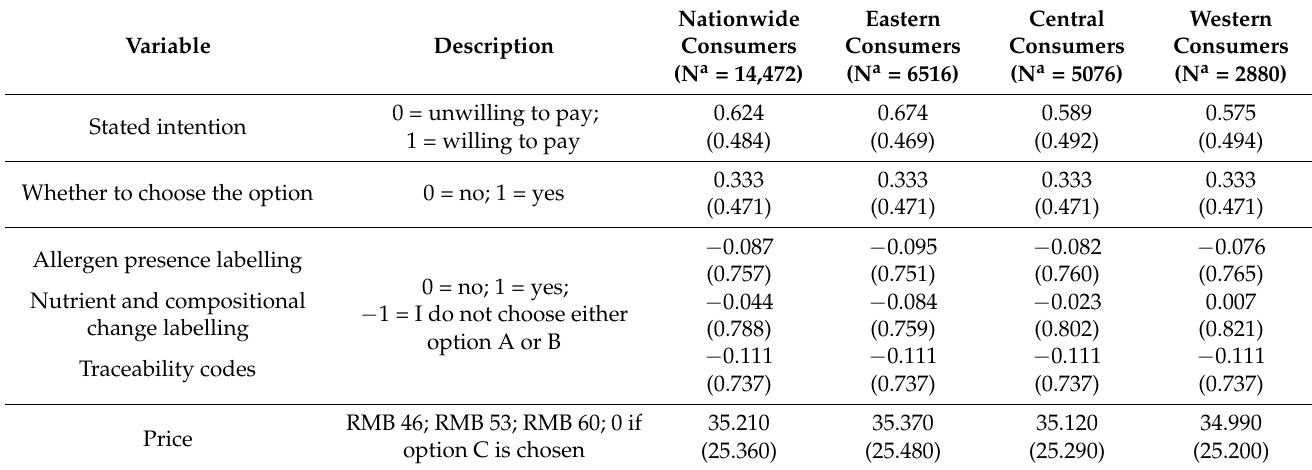
Table 3. Definition and descriptive statistics of the variables used in mixed logit